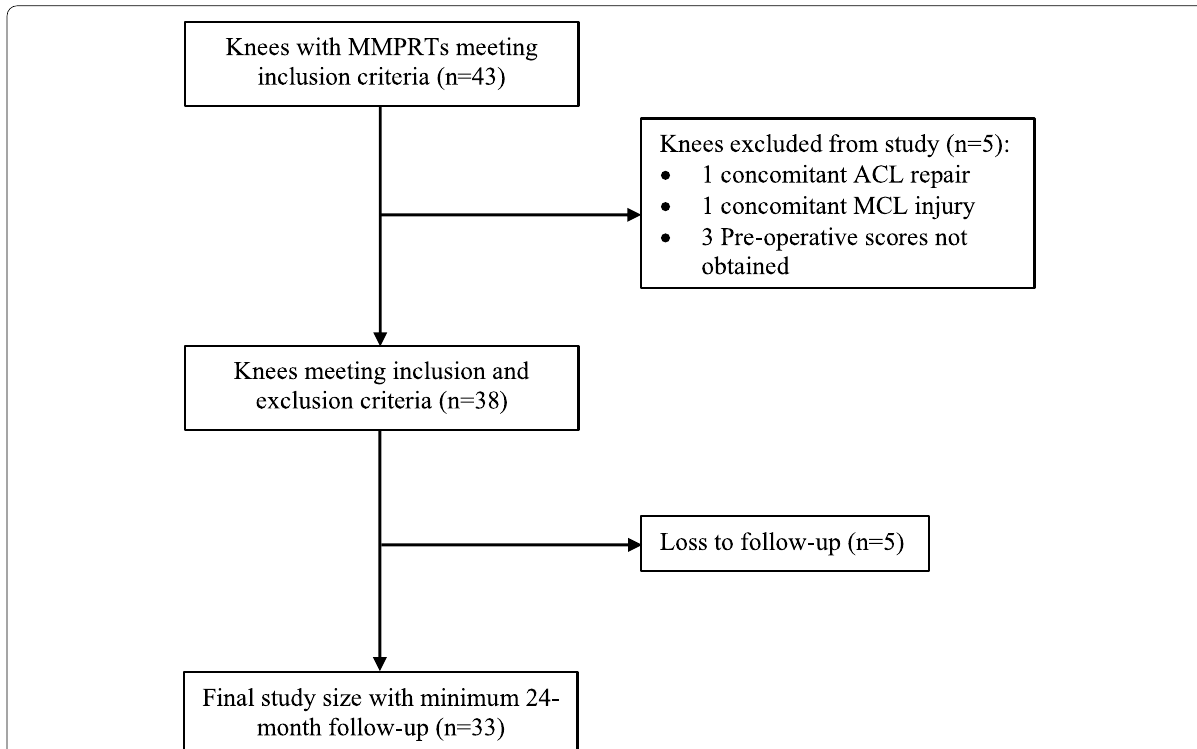
Fig. 1 Patient selection process for this study into medial meniscus posterior root tear (MMPRT) repair. Patients were recruited from November 2013 to October